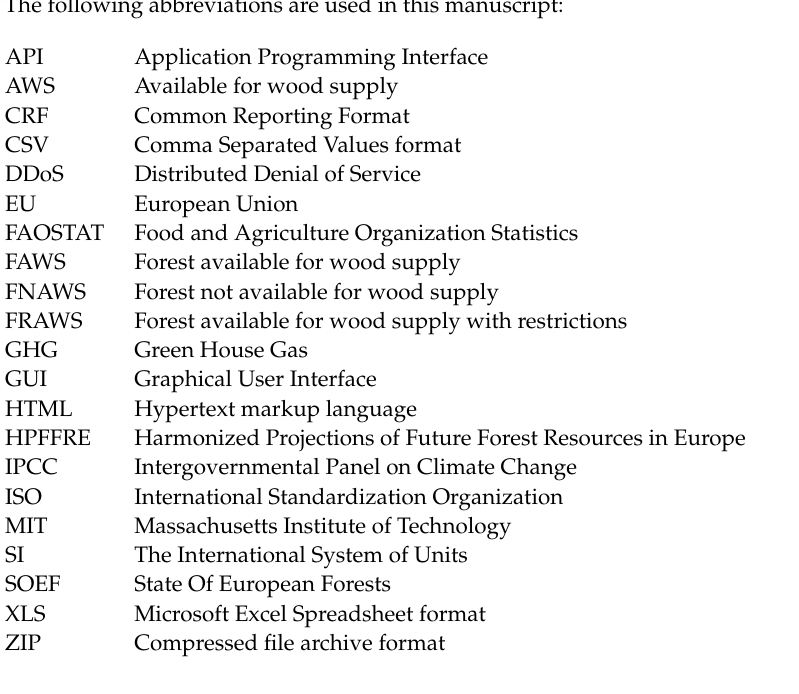
Table A1. Proportion of area Available for Wood Supply (AWS) and Forests with Restrictions